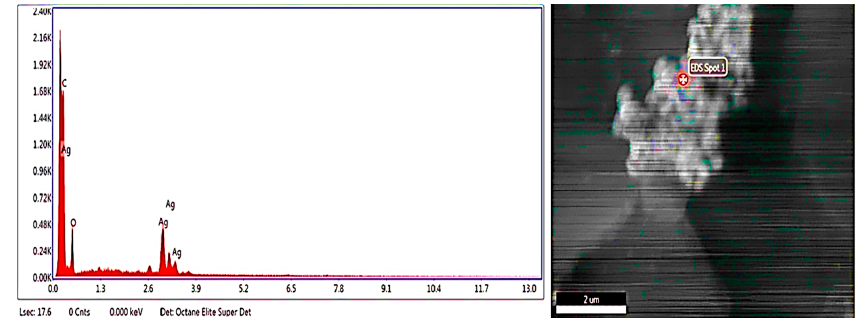
Figure 3. SEM analysis of AgNPs ( a ) SEM ( b ) Particle size distribution.